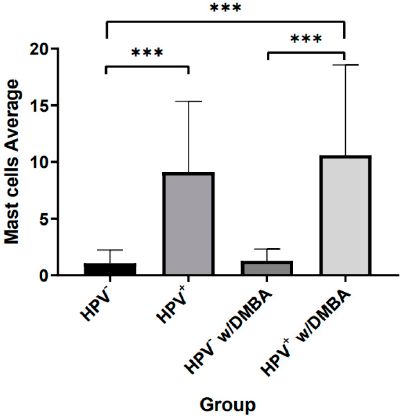
Figure 2. Mast cell infiltration in chest skin and ear tissue in the different groups. Transgenic mice (HPV + ) had a higher infiltration of mast cells when compared to the wild-type (HPV − ) (*** p < 0.001). DMBA presence did not alter the predisposition for mast cell infiltration in any of the groups. We also evaluated mast cell infiltration in the two organs separately. The mean num- ber of mast cells was higher in ear tissue when compared with chest skin (Figure 3). This alteration was perceptible in both wild-type (HPV − ) and transgenic mice (HPV + ), although it was much more evident in the HPV + groups, both without and with DMBA ( p < 0.01) (Figure 3). Figure 3. Mast cell differential infiltration in each group (chest skin and ear tissue together). There was an increase in mast cell infiltration in the ear tissue when compared to the chest skin, in both wild-type and transgenic mice. HPV − had a statistically lower difference between both organs (* p < 0.05), whereas in HPV + without and with DMBA, there was a higher statistically significant differ- ence (** p < 0.01). Next, we wanted to understand if mast cell infiltration increased as lesions pro- gressed from normal epidermis to epidermal hyperplasia, dysplasia and squamous cell carcinoma. Analyzing both organs together, we observed important differences between the normal epithelium and the hyperplastic epithelium ( p < 0.001), as well as between the normal epithelium and the dysplastic epithelium ( p < 0.001) (Figure 4a). No statistically significant difference was observed between the hyperplastic epithelium and the dysplas- tic epithelium ( p = 0.348) (Figure 4a). The evaluation of chest skin alone showed, once